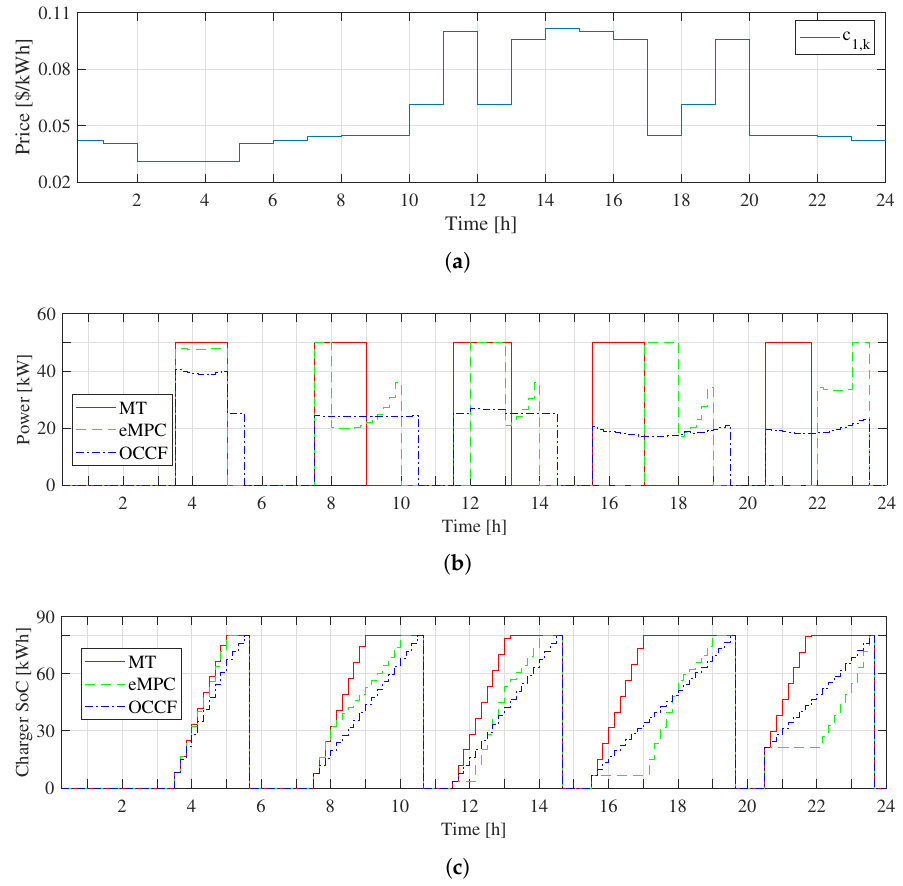
Figure 5. The behaviour of the three charging strategies in charger 1, considering only request parameters. ( a ) Energy price sequence c 1, k . ( b ) Power profiles P 1, k with the different strategies. ( c ) Charger SoC x 1, k with the different